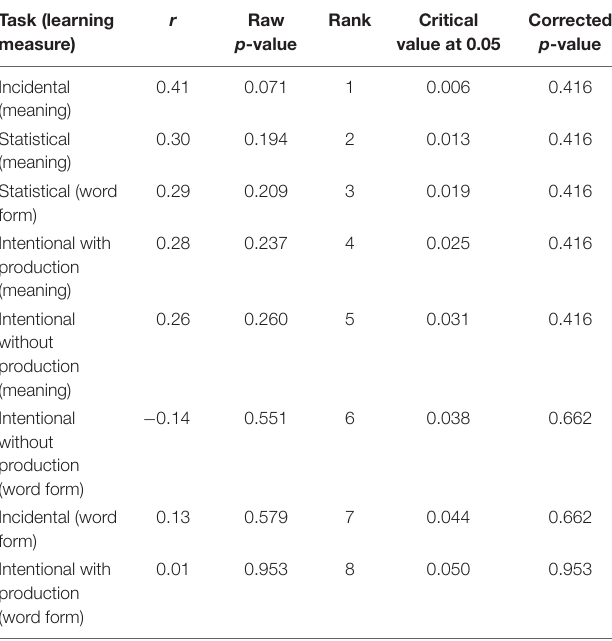
TABLE 7 | Correlations between Digit Span and learning performance with critical values of the Benjamini–Hochberg correction at an FDR of 0.05 and corrected p -values.